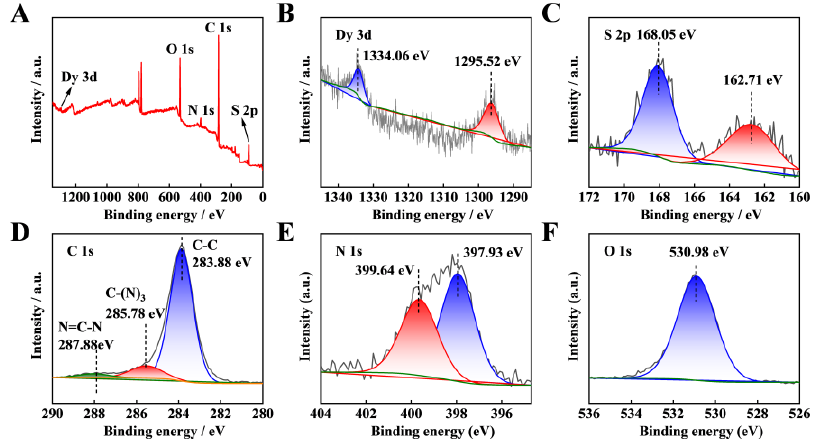
Figure 2. ( A ) Total X-ray photoelectron spectroscopy (XPS) spectra of Dy-OSCN/FTO electrode; high-resolution XPS spectra of ( B ) Dy 3d, ( C ) S 2p, ( D ) C 1s, ( E ) N 1s, and ( F ) O 1s.